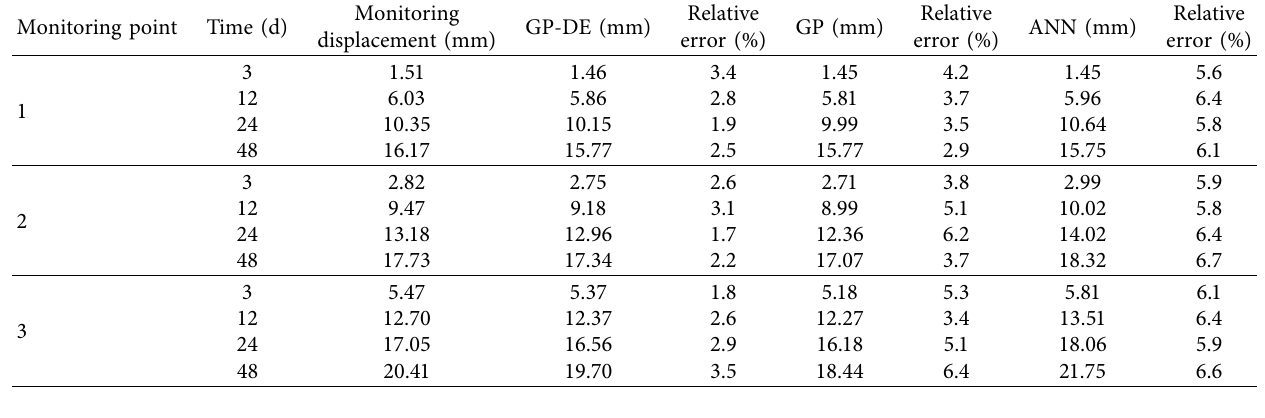
Table 7: Comparison results of different algorithms.